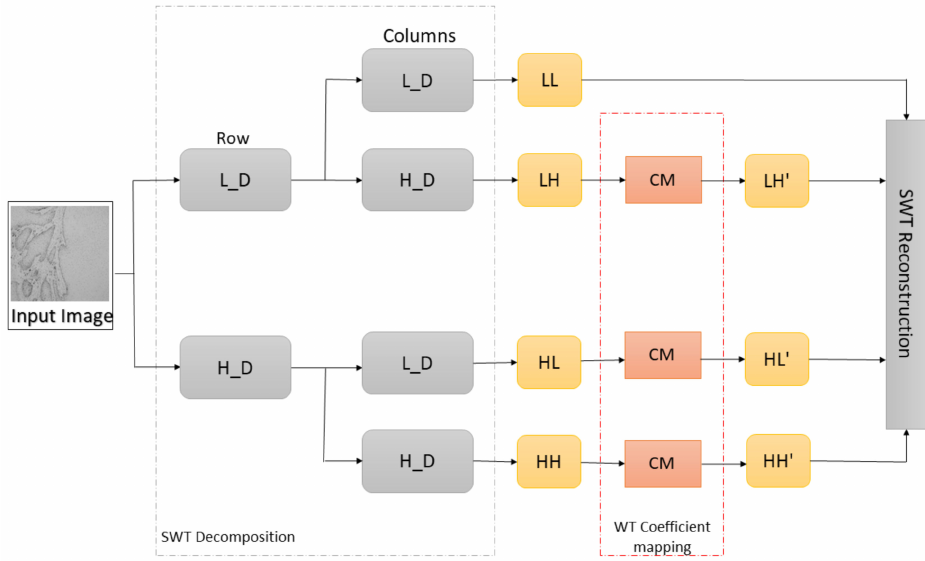
Figure 4. Representation of SWT decomposition, wavelet coefficient mapping, and SWT reconstruction (L_D—low pass filter, H_D—high pass filter, LL—approximation coefficients, LH—horizontal coefficients, HL—vertical coefficients, HH—diagonal coefficients, and CM–coefficient mapping function).